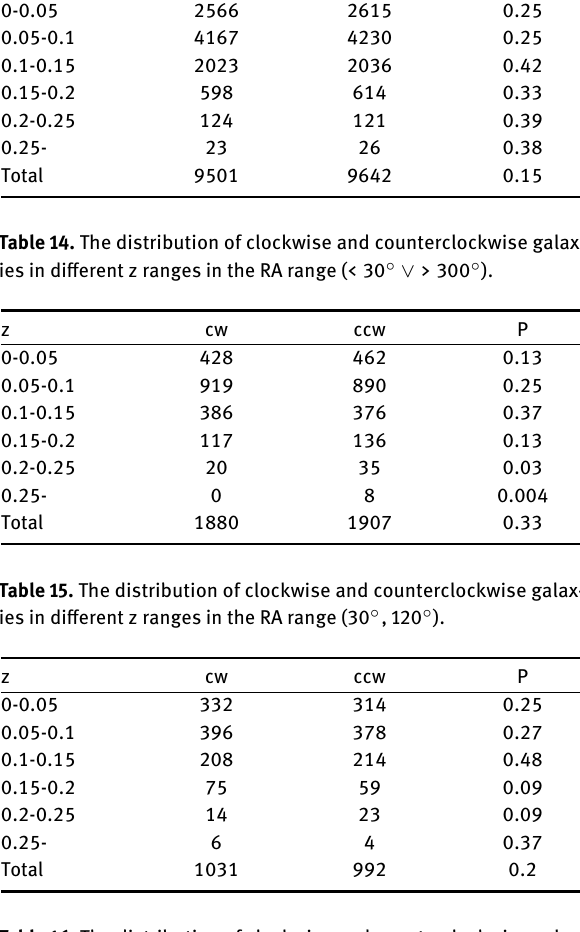
Table 16. The distribution of clockwise and counterclockwise galax- ies in different z ranges in the RA range (210 ∘ , 300 ∘